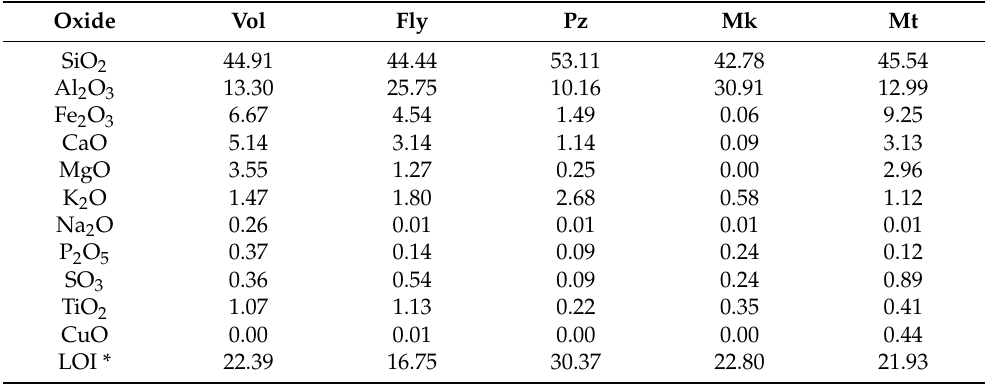
Table 1. Chemical composition of volcanic ash (Vol), fly ash (Fly), pozzolan (Pz), metakaolin (Mk), and mining tailings